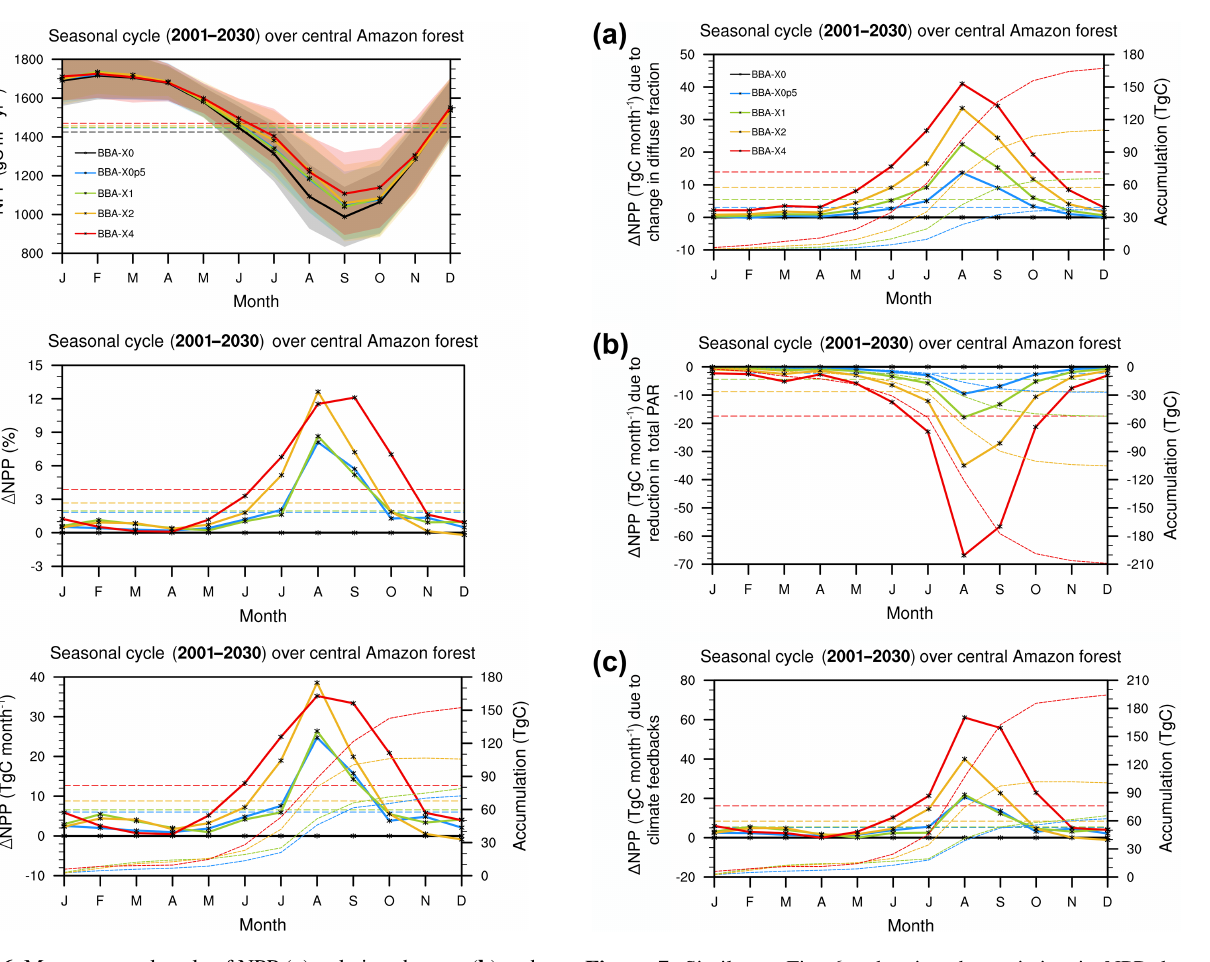
Figure 7. Similar to Fig. 6c, showing the variation in NPP due solely to (a) change in diffuse fraction, (b) reduction in total PAR and (c) the climate